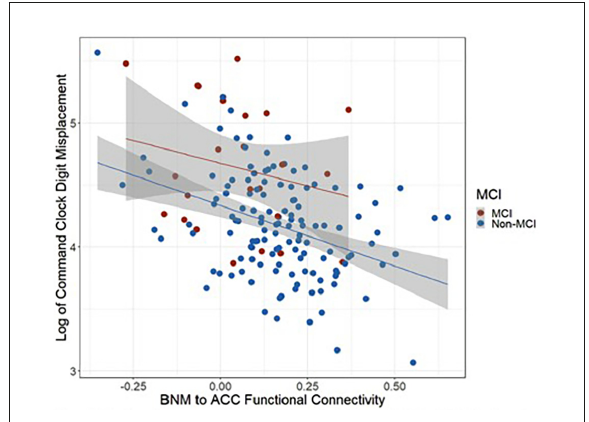
FIGURE4 Scatter plot representing the relationships between BNM to ACC functional connectivity and command digit